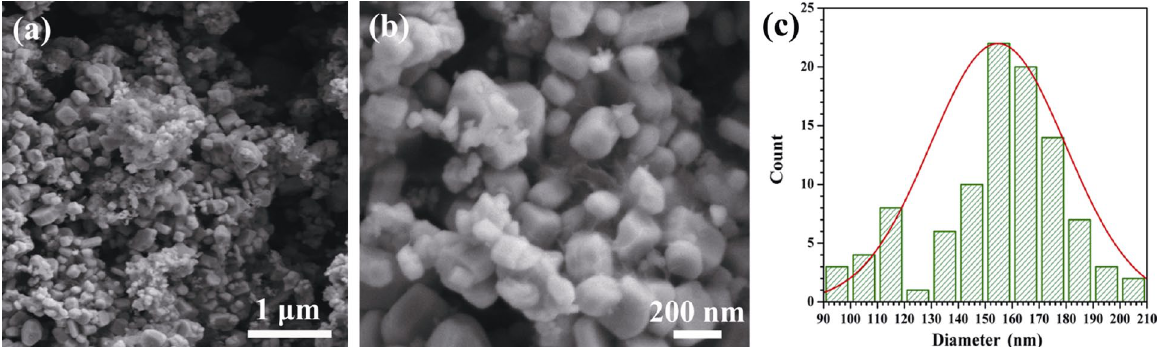
Fig. 2 SEM characterizations of HfB 2 products synthesized at 1373 K with molten salts: (a) low magnification SEM image and (b) high magnification SEM image. (c) Histogram of each measured data for the particle sizes with a Gaussian fitting to the data. The Gaussian peak is centered at 155